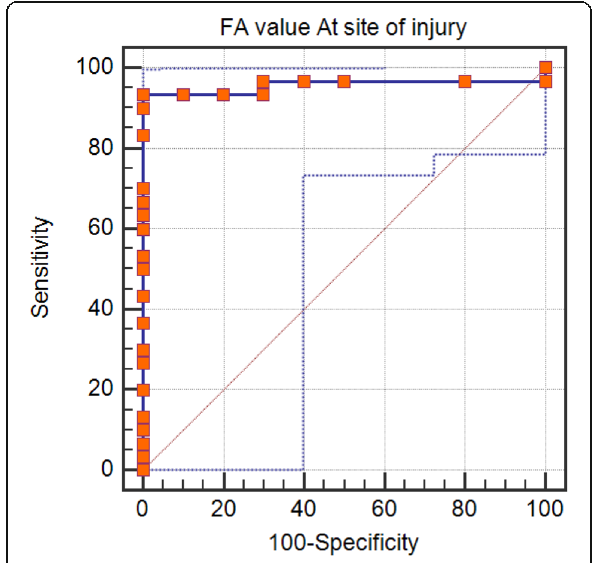
Fig. 6 ROC curve between patients and control groups according to